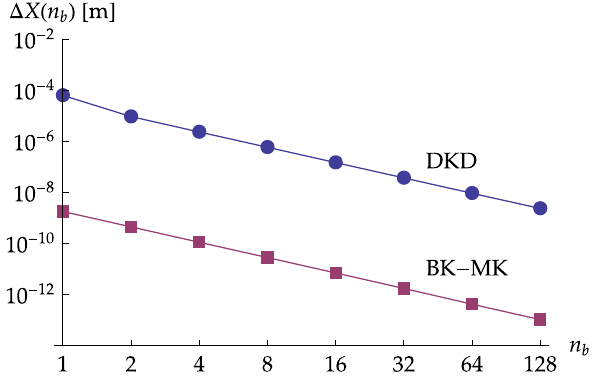
FIG. 4. One-turn errors in X versus n (upper curve), and BK/MK integration (lower curve). The errors were computed by comparing with a data set produced using BK/MK integration and n